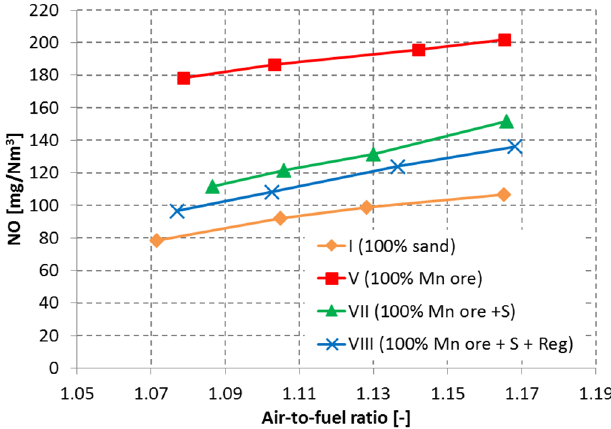
Figure 7. Measured concentrations of NO (mg/nm 3 , at 6% O 2 ) at position kh2 in the convection path as a function of the air ‐ to ‐ fuel ratio for experiments with partial substitution of sand with manganese ore.